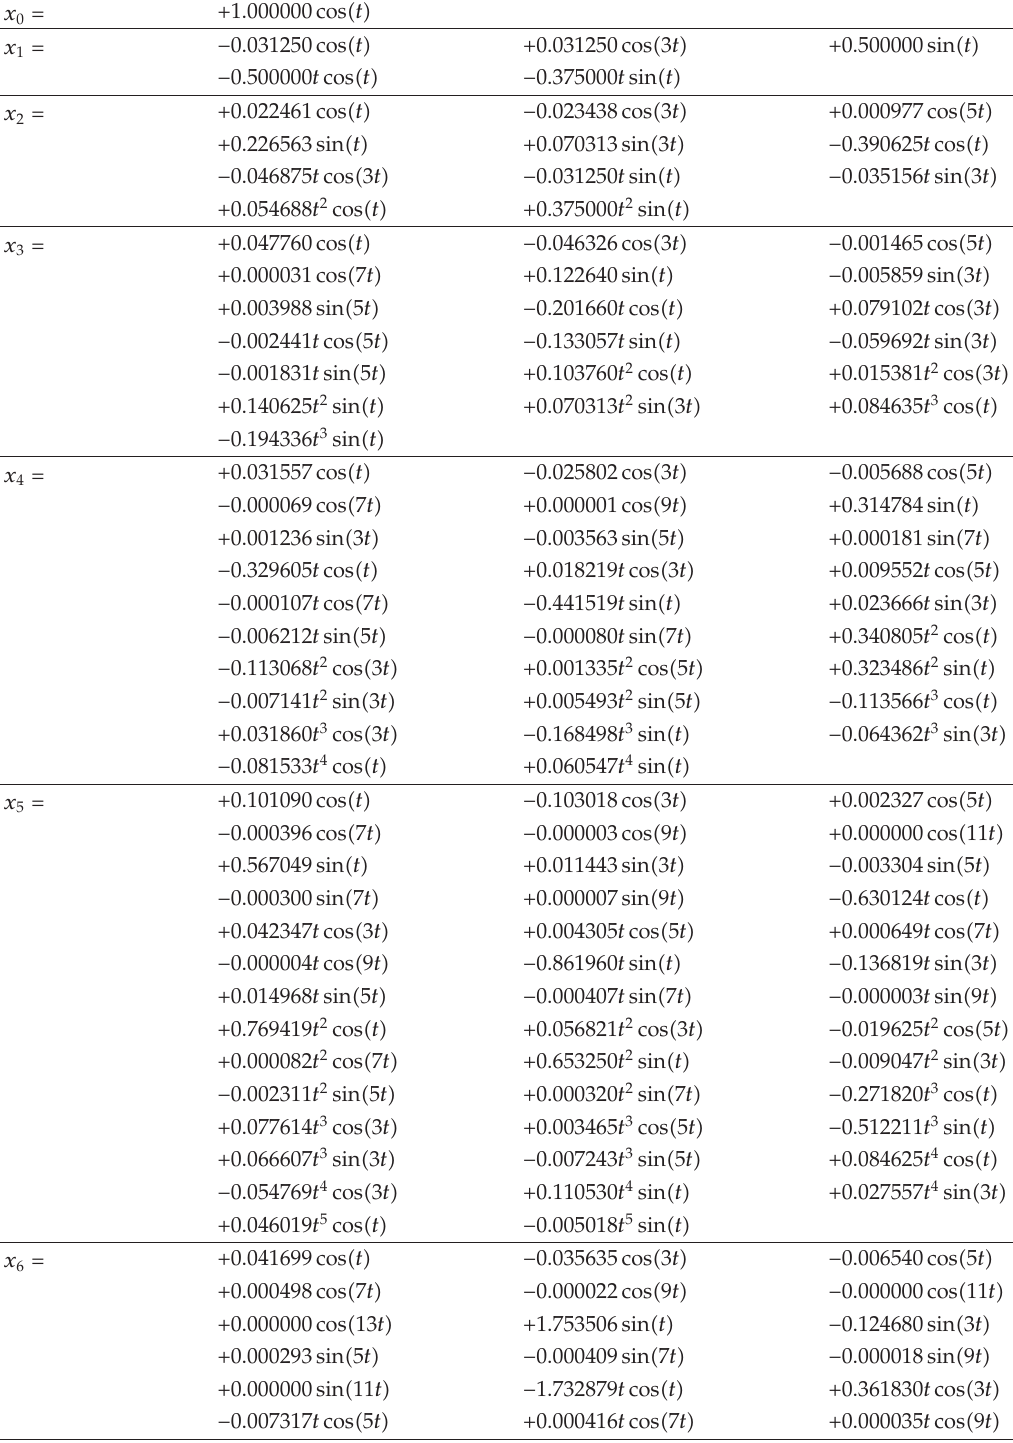
Table 2: Some coe ffi cients of the asymptotic expansion of the solution to (cid:3) 7.1 (cid:4)